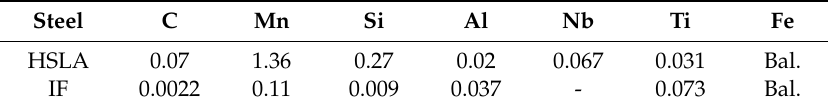
Table 1. Basic chemical compositions of the studied steels (in wt